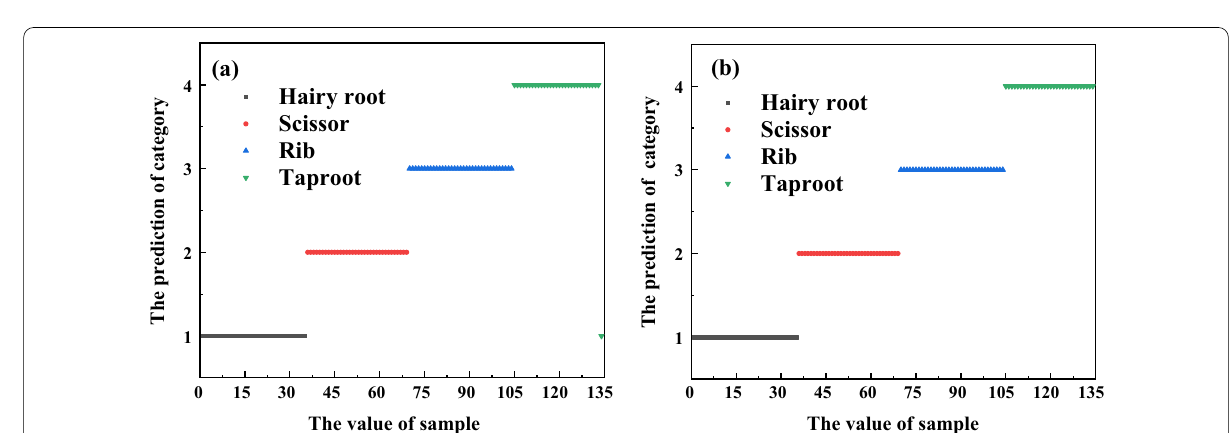
Fig. 7 Test results of the LDA model, a is the LDA model without pretreatment; b is the LDA model with baseline